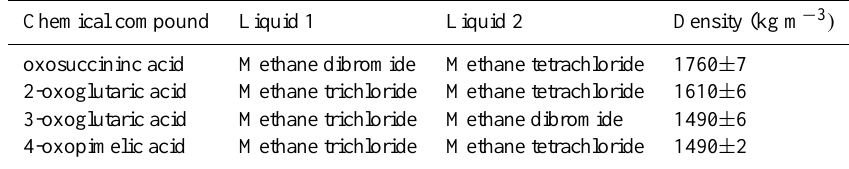
Table 2. Measured densities of the four oxo-compounds and the liquids used to determine